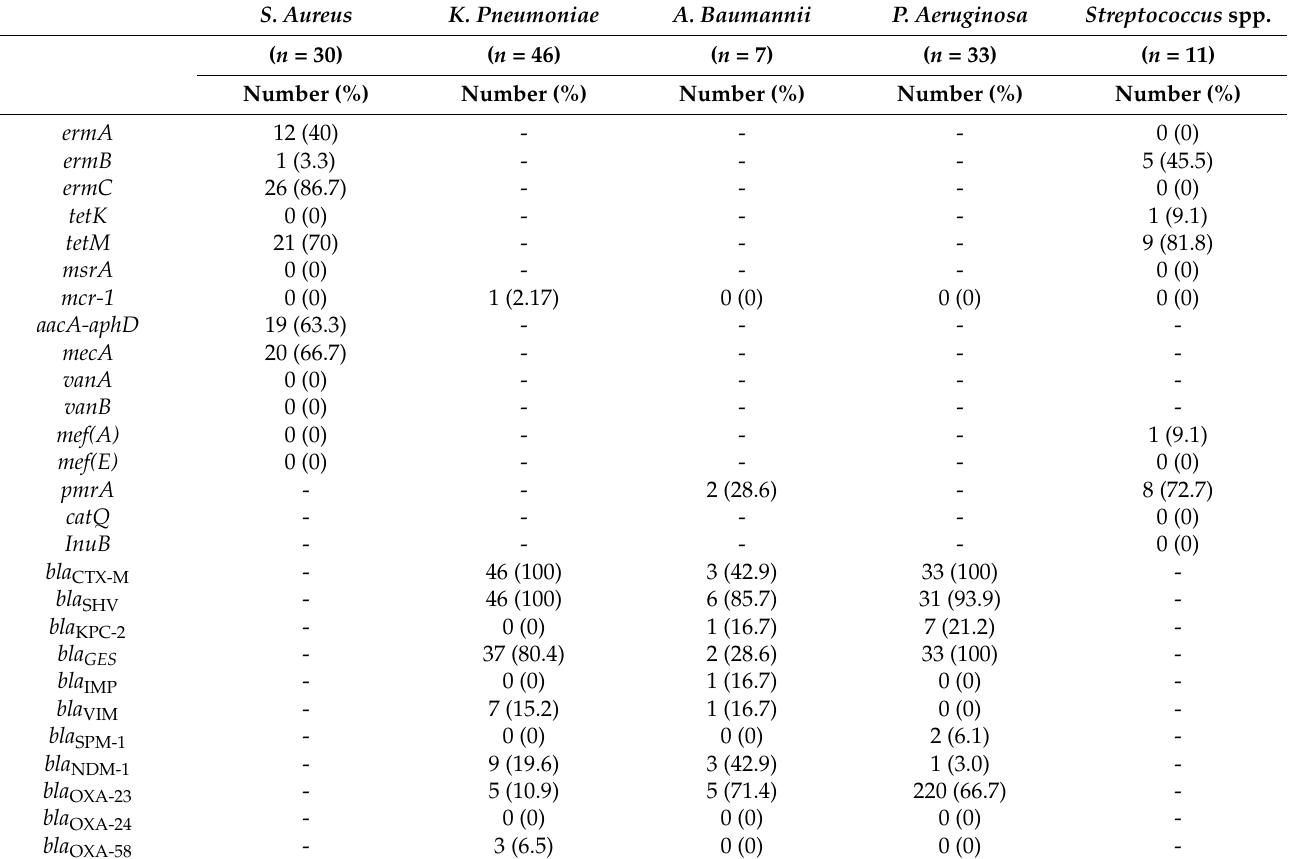
Table 3. Antibiotic resistance genes detected in clinical